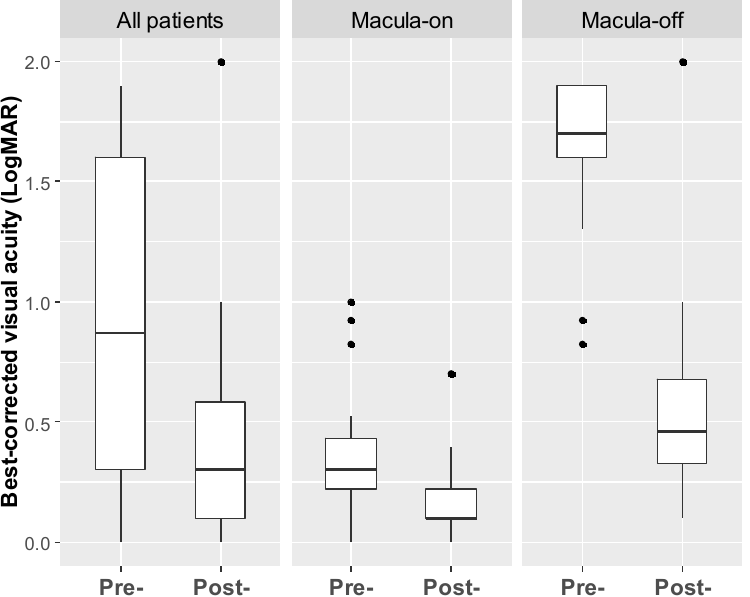
Figure 2. Box-and-whisker plot showing preoperative and postoperative best-corrected visual acuity (LogMAR) in RRD patients undergoing our two-step PR treatment.